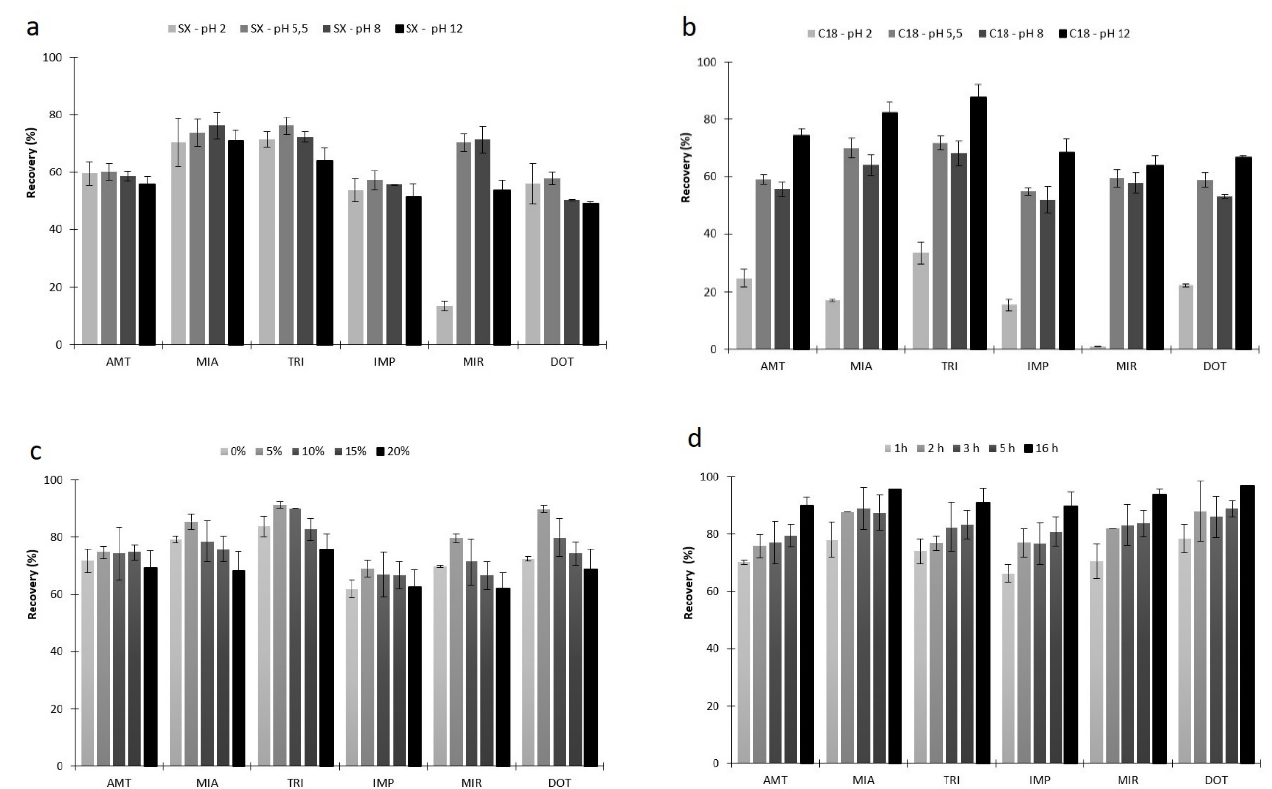
Figure 4. Effect of matrix pH using SX ( a ) and C 18 ( b ) sorbent phases, percentage of NaCl ( c ) and equilibrium time ( d ) on the microextraction efficiency of six TCAs in aqueous media by BAμE-μLD/LVI-GC-MS(SIM). The error bars represent the standard deviation of three replicates.